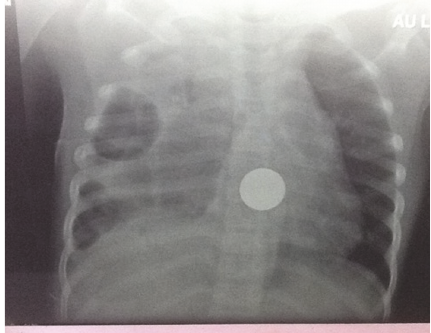
Figure 7: Chest X-ray of the same girl 12 days after admission, loculated empyema, and foreign body at almost the same